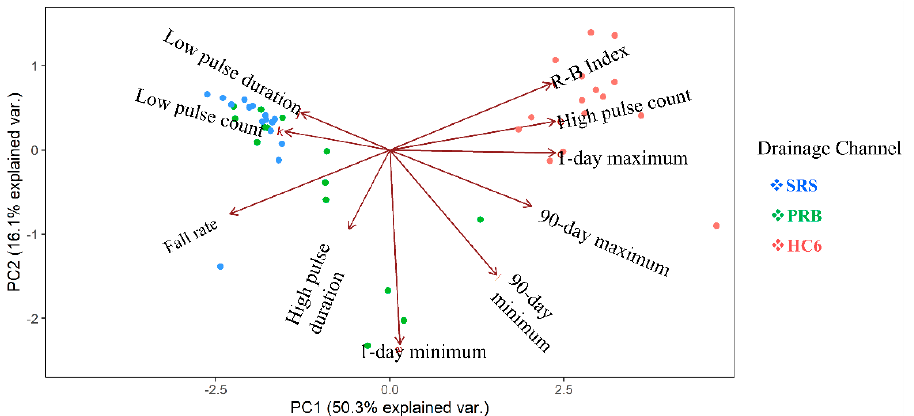
Figure 3. Principal component analysis plot of the hydrologic indices used to characterize the flow regimes of SRS, PRB, and HC6.